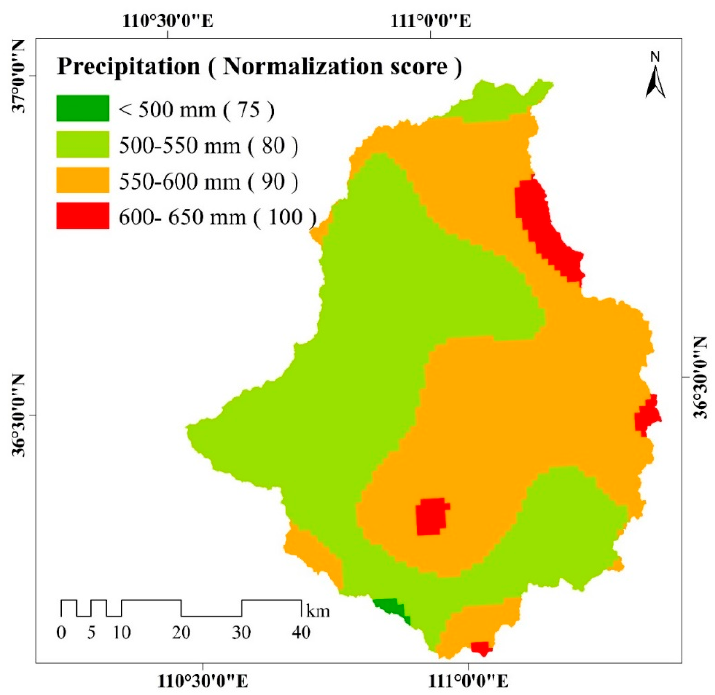
Figure 8. Spatial distribution of precipitation in the study area. Precipitation is classified into four classes: <500 mm, 500–550 mm, 550–600 mm and 600–650 mm. The different colors represent different precipitation classes. Higher normalization score of precipitation represent a greater impact on soil erosion.